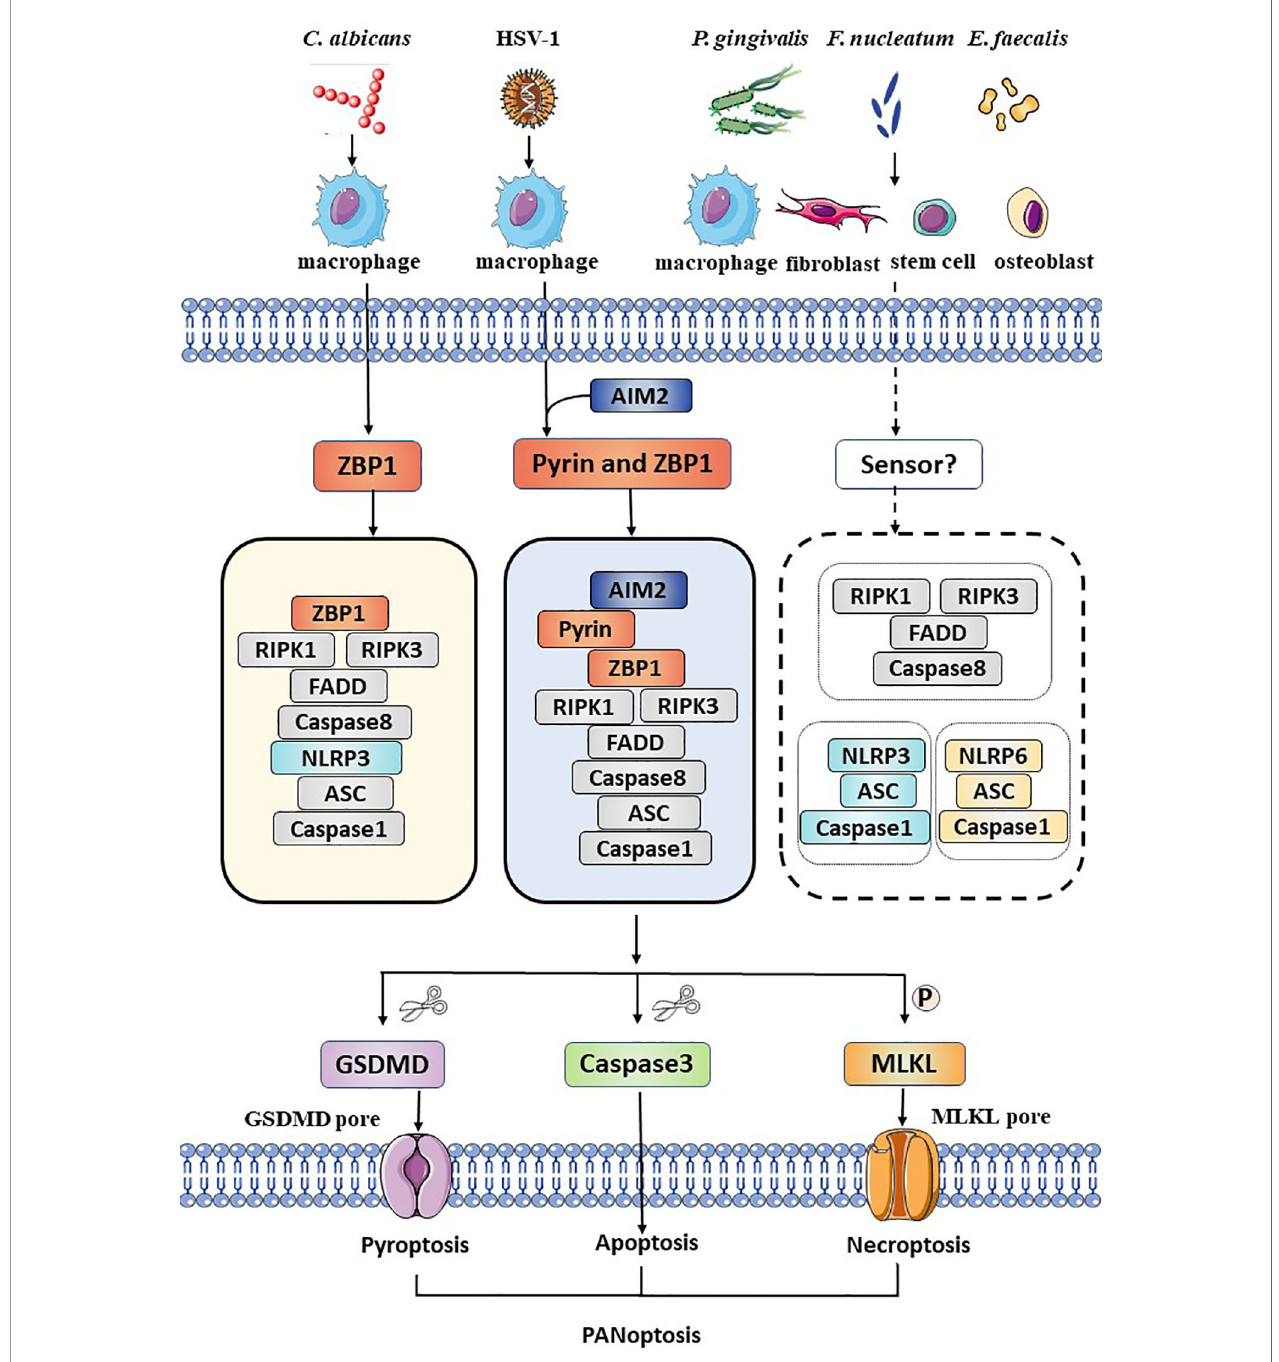
FIGURE 1 | Schematic summary of the activation of PANoptosis in several kinds of cells during oral pathogens infection. During Candida albicans infection, ZBP1 senses the pathogen and recruits RIPK3, RIPK1, and caspase-8 to assemble the ZBP1 PANoptosome, causing GSDMD-mediated pyroptosis, caspase-8- dependent apoptosis and MLKL-mediated necroptosis (PANoptosis). DNA virus, HSV-1, is sensed by ZBP1 and pyrin and actives the AIM2 PANoptosome which inducing PANoptosis in macrophages. Bacteria such as Porphyromonas gingivalis , Fusobacterium nucleatum , and Enterococcus faecalis active pyroptosis, apoptosis, necroptosis and release intracellular cytokines and DAMPs not only in immune cells, but also in fi broblasts, stem cells and osteoblasts. However, the exact sensor is unclear. The NLRP3 in fl ammasome, the NLRP6 in fl ammasome and the necroptosome are involved, but the interaction among these molecules remains